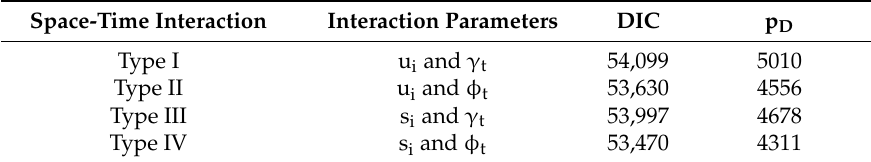
Table 3. Deviance Information Criterion (DIC) values for models with Type I, II, III, and IV space-time